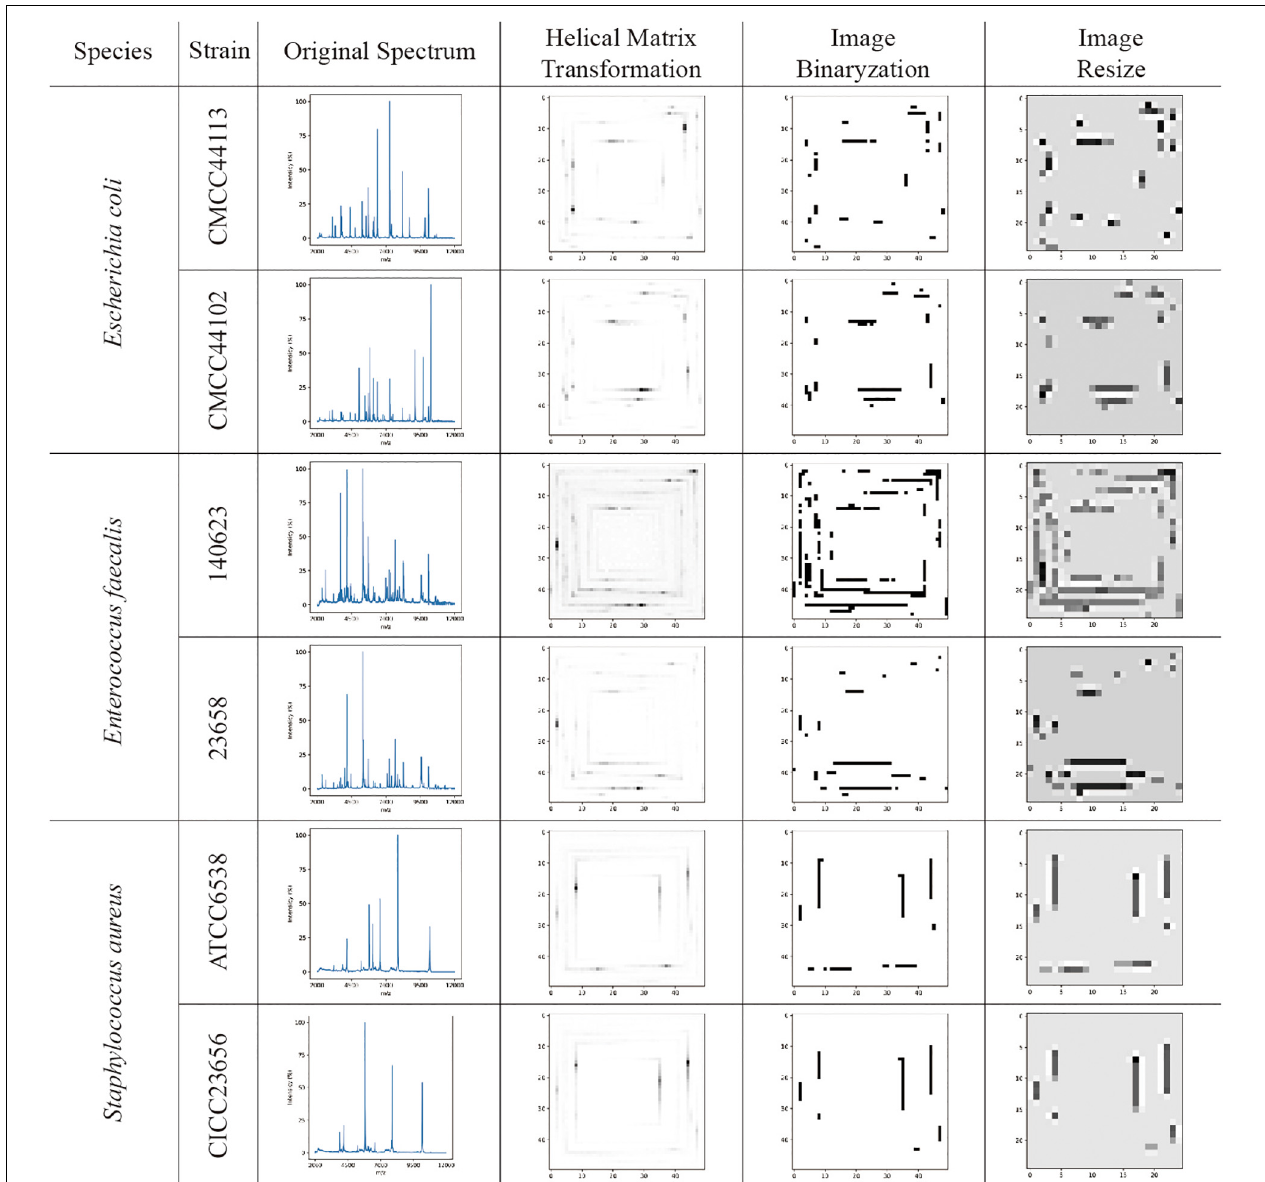
FIGURE 2 | The visualization examples of original MS spectra; images converted by the helix matrix transformation; images after binarization; and resized images of Escherichia coli , Enterococcus faecalis , and Staphylococcus aureus species, respectively. The lines with various shades of gray to black shown in the images are the MS peaks after data